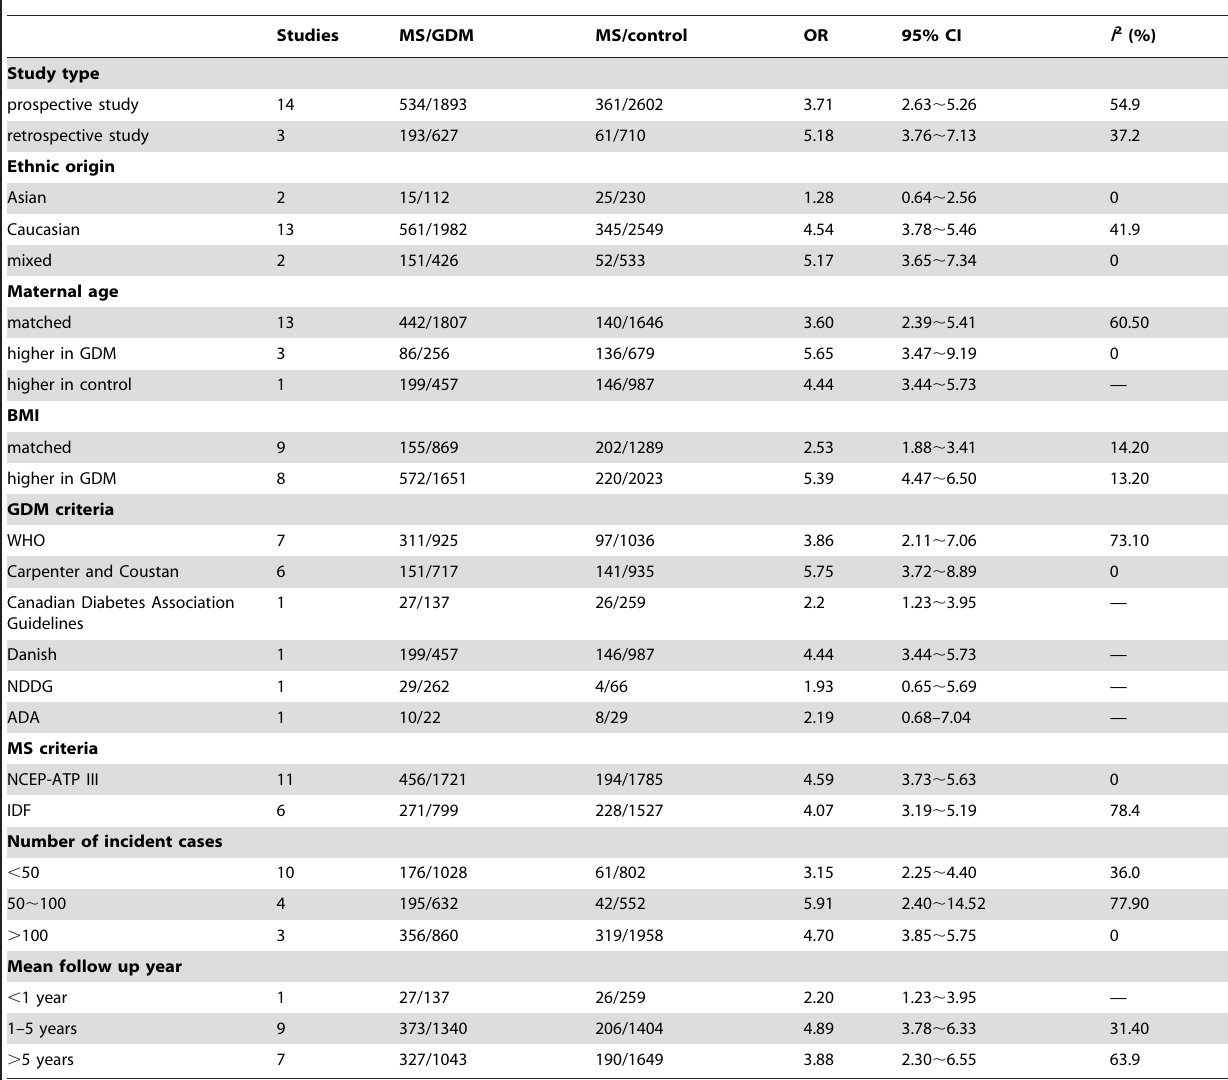
Table 2. Subgroup analysis of the risk of MS after